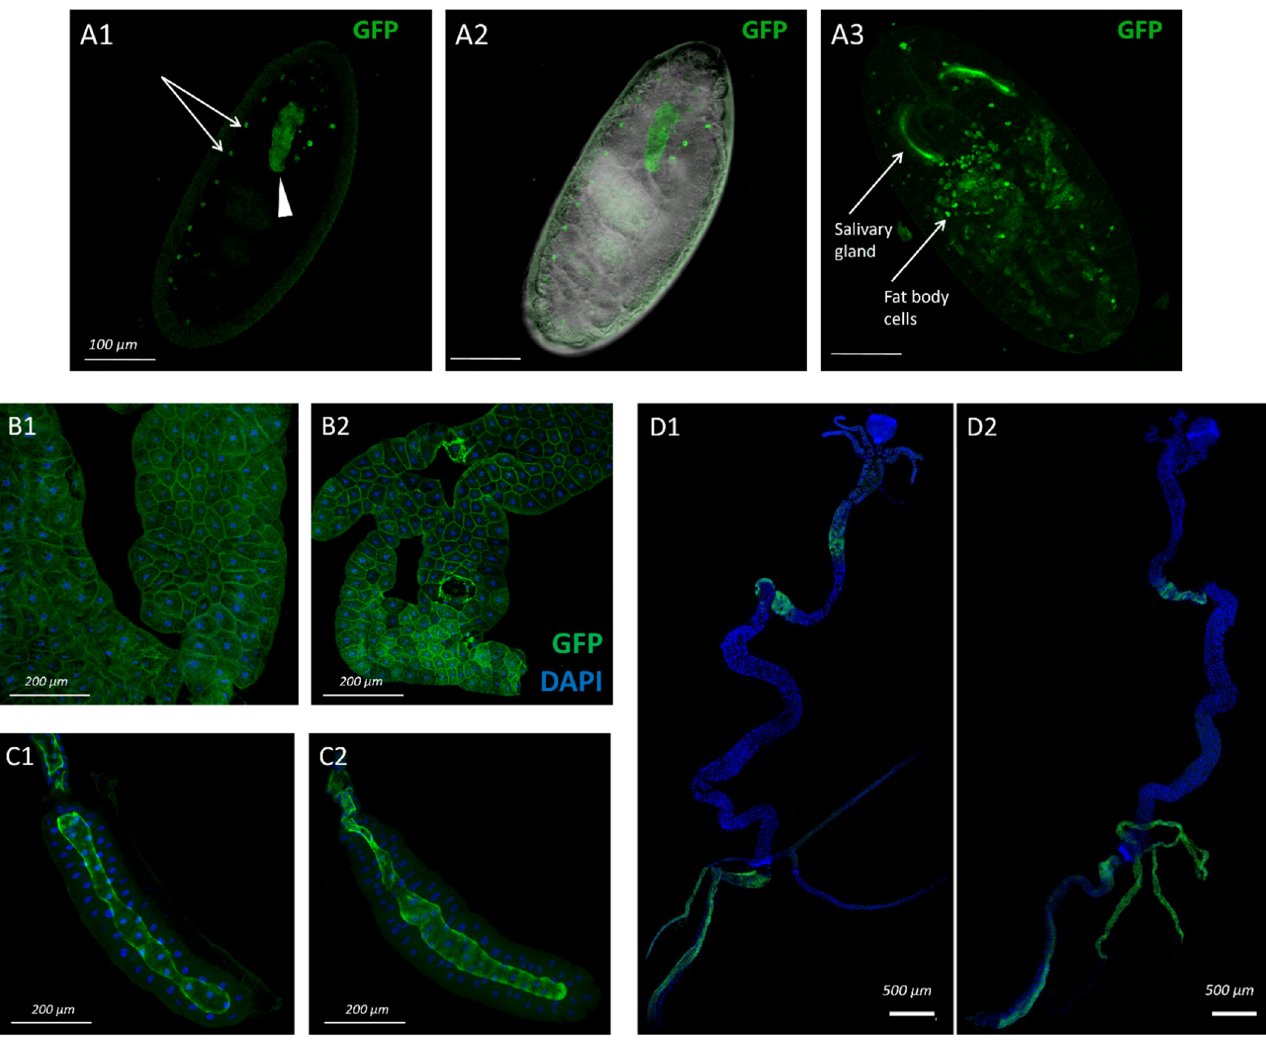
Figure 1. The cells and organs with GFP (green) expression in specimens with sws-GAL4;UAS-CD8-GFP genotype. ( A ) Embryo and ( B – D ) third instar larva. ( A1 , A2 ) Images of the embryo of the stage 16: ( A1 ) confocal image showing GFP distribution, ( A2 ) merged images (light + confocal) showing inner structure of the embryo and GFP. Metameric dots (presumably, according to sensilla) are marked with arrows, and the salivary gland is marked with the arrowhead. ( A3 ) Stage 17 of embryo development; salivary glands and fat body cells are marked with arrows. ( B ) Fat body, ( C ) salivary gland, ( D ) intestine and Malpighian tubes of ( B1 , C1 , D1 ) male and ( B2 , C2 , D2 ) female. ( B – D ) Nuclei are stained with DAPI (blue). Scale bar: ( A )—100 µm, ( B , C )—200 µm, ( D )—500 µm.